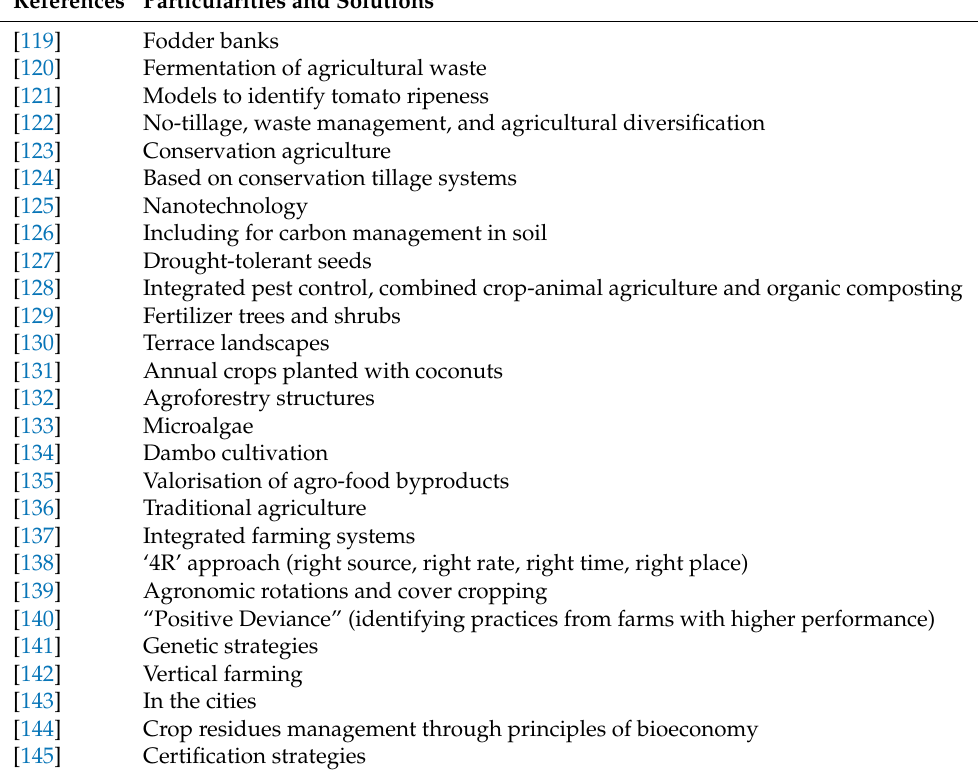
Table 4. Particularities and solutions highlighted by the literature for a more balanced agricultural